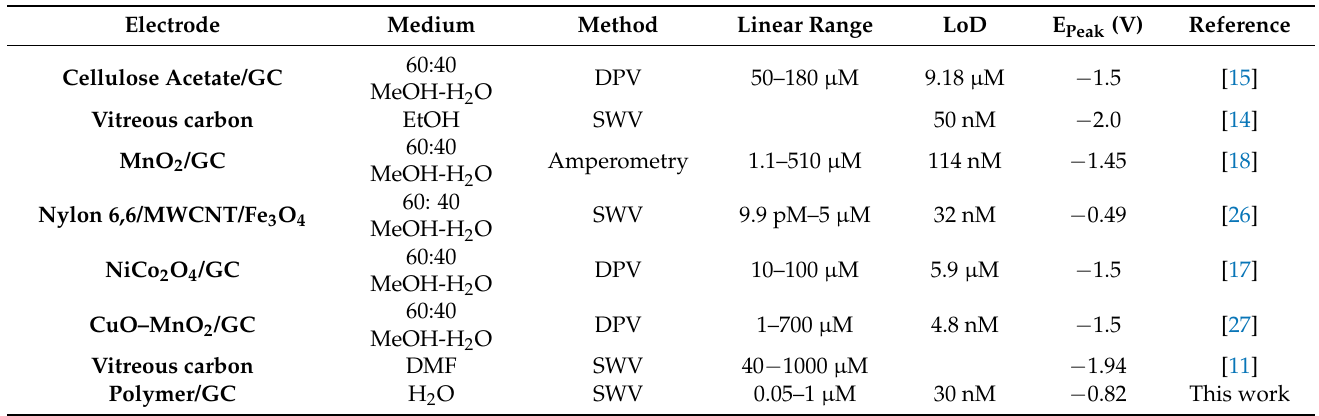
Table 1. Comparison of different electrochemical methods reported for the determination of